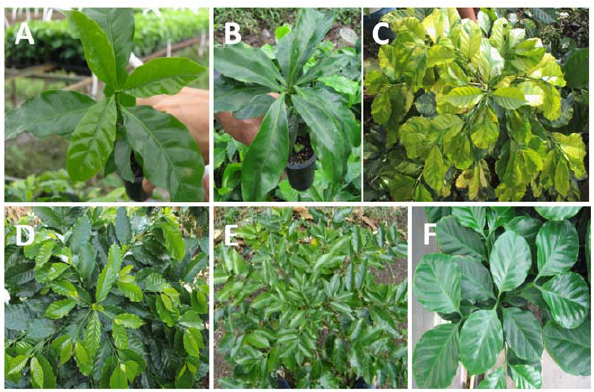
Figure 3. Examples of different C.arabica phenotypic variants in plants mass propagated through somatic embryogenesis. A, plant exhibiting a normal phenotype in the nursery; B, Angustifolia variant in the nursery; C, Variegata variant in the field; D, plant showing a normal phenotype in the field; E, Dwarf variant in the field; F, Bullata variant in nursery.